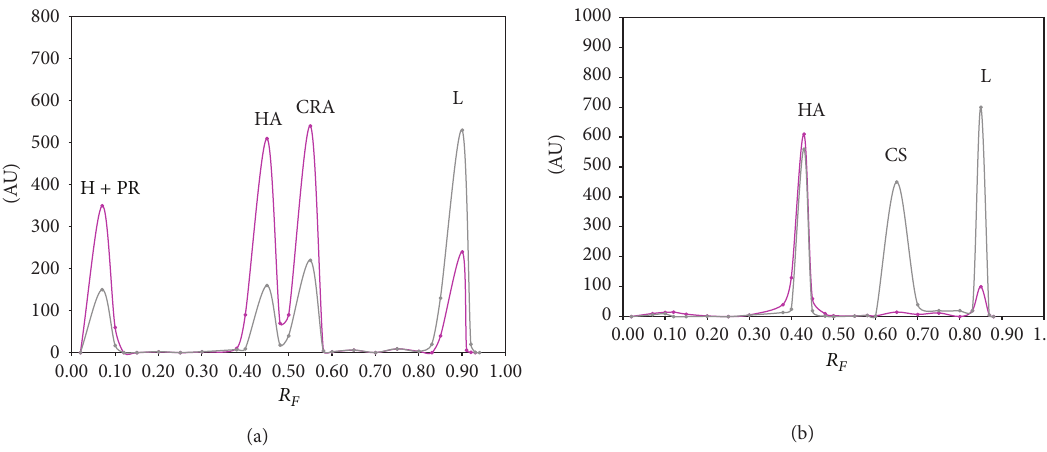
Figure 1: (a) Densitogram of the combine standard solution containing the following reference substances: lidocaine hydrochloride (L), hydrocortisone acetate (HA) and its related substances, namely, hydrocortisone (H), prednisolone (PR), and cortisone acetate (CRA) and (b) densitogram of drug sample analyzed by NP-TLC, at wavelengths of 200 nm and 250 nm obtained under optimum chromatographic conditions.